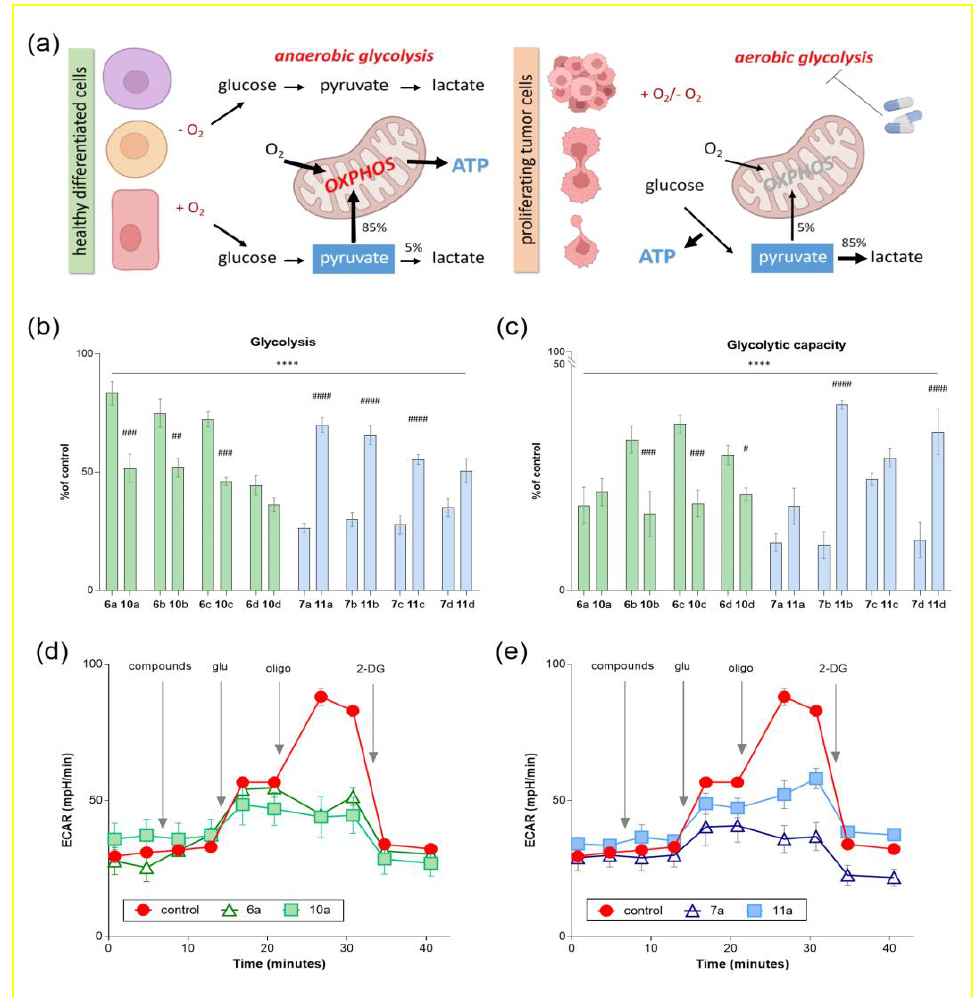
Figure 3. Influence of conjugates of dehydrocostuslactone and alantolactone with alkoxy-substituted benzyl azides on the process of glycolysis of the tumor neuroblastoma cell line SH-SY5Y. ( a ) Schematic representation of differences in the metabolism of normal and tumor cells. An increase in the rate of glucose uptake and preferential production of lactate is defined as the Warburg Effect. The influence of the studied compounds on the main calculated parameters of the glycolytic function of SH-SY5Y: ( b ) glycolysis (the difference between the extracellular acidification rate (ECAR) with the addition of glucose and basal glycolysis); ( c ) glycolytic capacity (the difference between the rate of extracellular acidification of the medium with the addition of the ATP synthase blocker oligomycin and basal glycolysis). Data are presented as a percentage relative to control (as mean ± SEM ( n = 3)). **** p ≤ 0.0001 compared to control, # p ≤ 0.05, ## p ≤ 0.01, ### p ≤ 0.001 and #### p ≤ 0.0001 compared to the corresponding long spacer conjugate (one-way ANOVA). Kinetic curves of changes in the glycolytic profile under the action of conjugates ( d ) dehydrocostuslactone 6a and 10a and ( e ) alantolactone 7a and 11a with aromatic alkoxy derivatives. The concentration of the studied compounds was 100 µM, glucose was 10 mM, oligomycin was 1 µM, and 2-fluoro-2-deoxy-D-glucose was 25 mM.